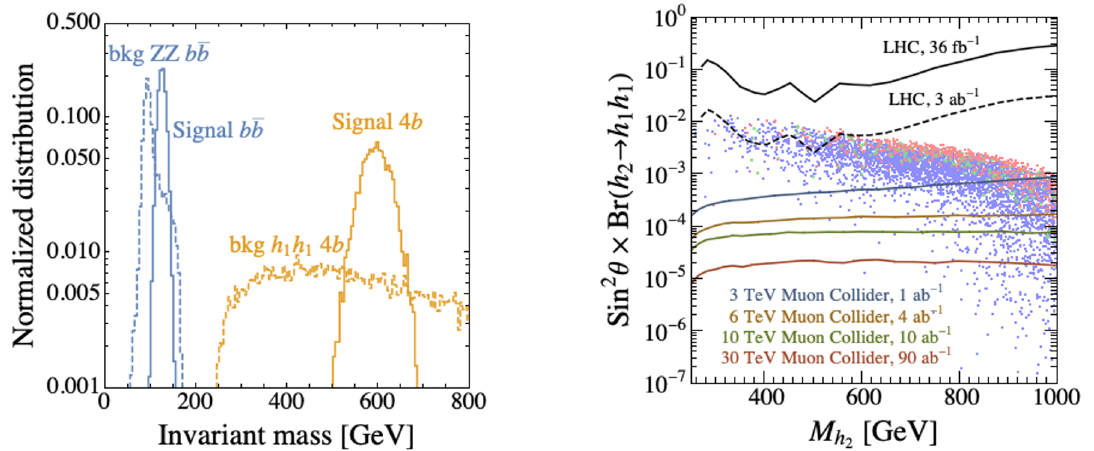
Figure 3 . Left: after the basic acceptance cuts, the invariant mass distributions of the jet pairs and four-jet system for the signal and main backgrounds at the 10 TeV muon collider. Here we select M h = 600 GeV as the signal benchmark. Right: the expected probe limits on s 2 2 for different muon collider setups. The scatter points are the FOEWPT data, in which red, green and blue colors represent SNR ∈ [50 , + ∞ ) , [10 , 50) and [0 , 10) , respectively. The limit from ATLAS at the 13 TeV LHC with L = 36.1 fb − 1 [119] and its extrapolation to the HL-LHC [12] are also shown for